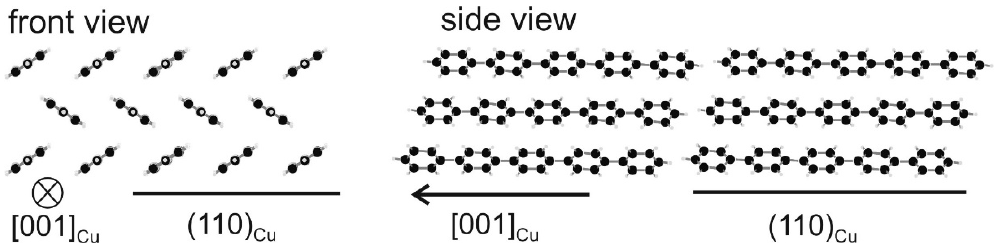
Figure 4. Real space view of the quinquephenyl bulk structure relative to the substrate surface and relative to the [001] Cu direction drawn in a front view and in a side view. The row of oxygen atoms on the Cu(110)(2×1)O surface are aligned along [001] Cu .